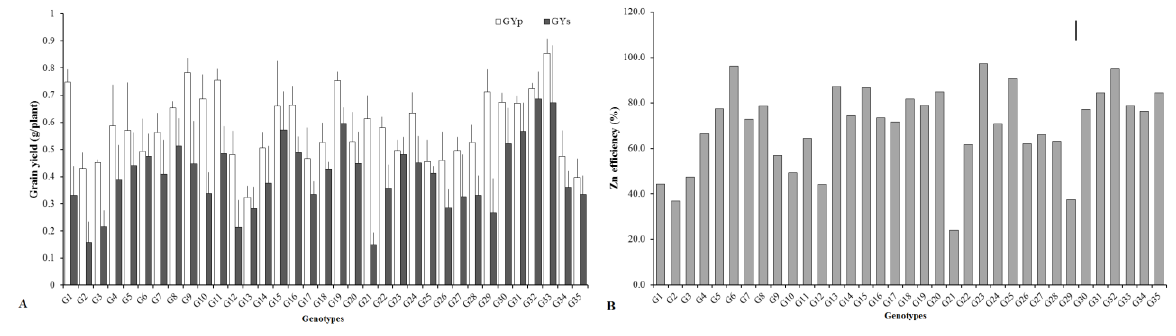
Fig. 1. The amounts of yields in normal (grain yield potential, GYp) and zinc-deficient (grain yield stress, GYs) conditions (A) and Zn efficiency (B) in 35 durum wheat genotypes. Vertical lines indicate standard error (SE) and vertical bar on the corner represent DMRT ( P < 0.05 ) for the comparison between the genotypes. The numbers inside the figure are genotypes code (see Table 1). Zinc efficiency was calculated as [(grain yield at Zn stress condition/grain yield at the normal condition) ×